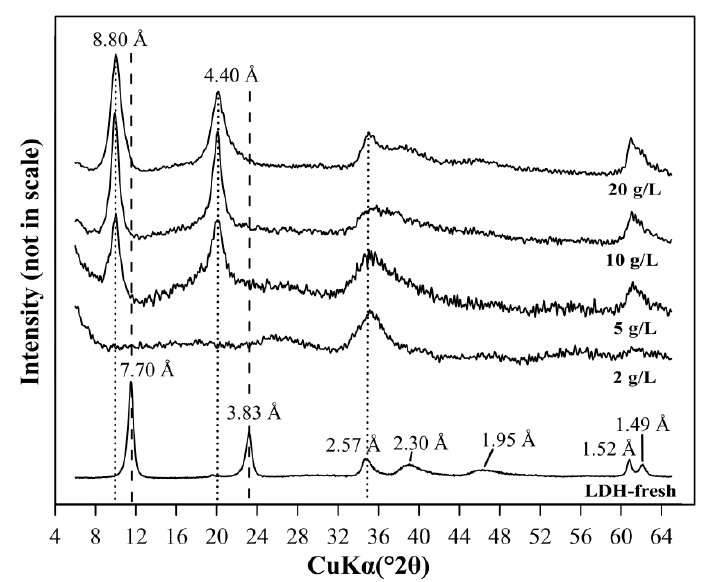
Figure 2. The XRD patterns of LDH before acid mine drainage ( AMD) treatment (LDH-fresh) and LDH after AMD treatment in the function of dosage.